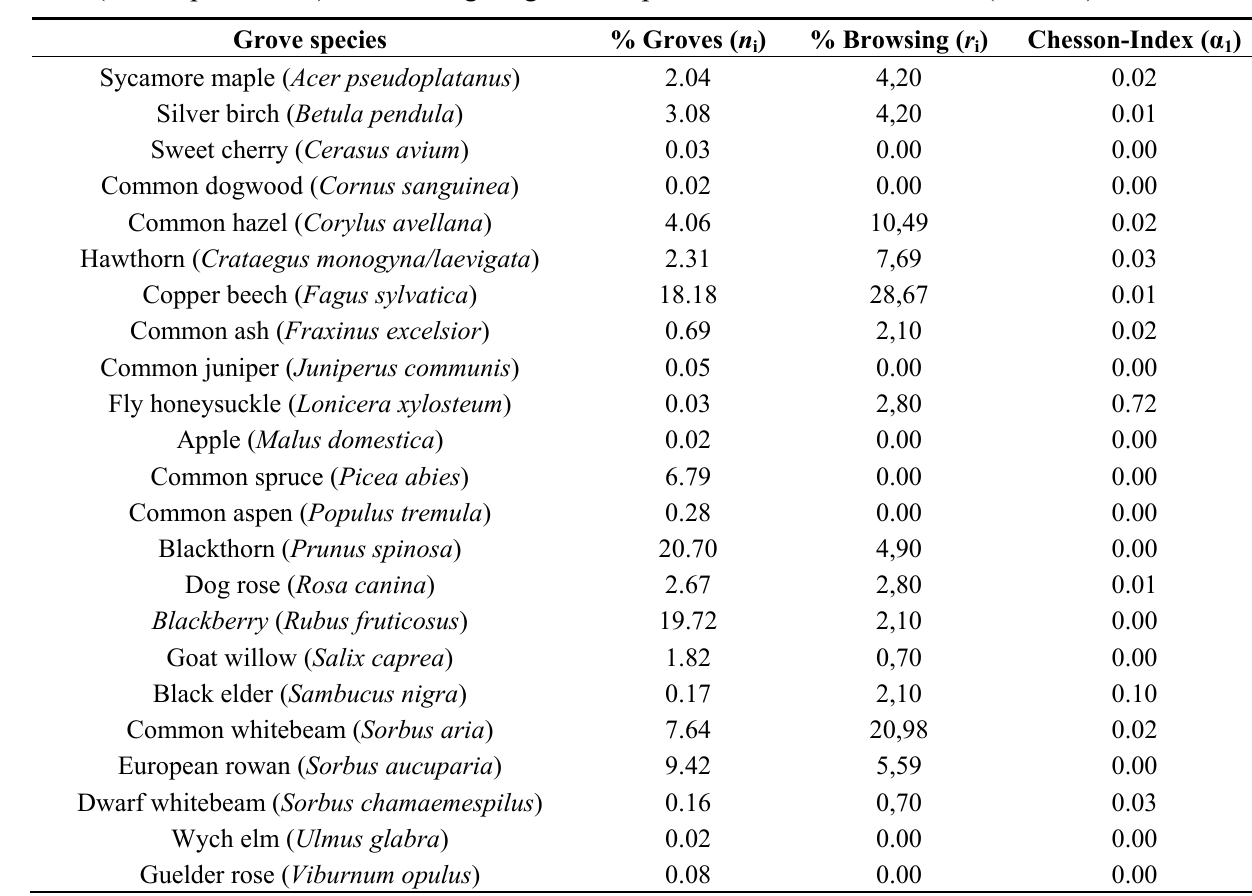
Table 3. Frequency of grove species, frequency of browsing and Chesson-Index (bold = preference) of browsing on groves in pastures of the Black Forest ( n = 143).